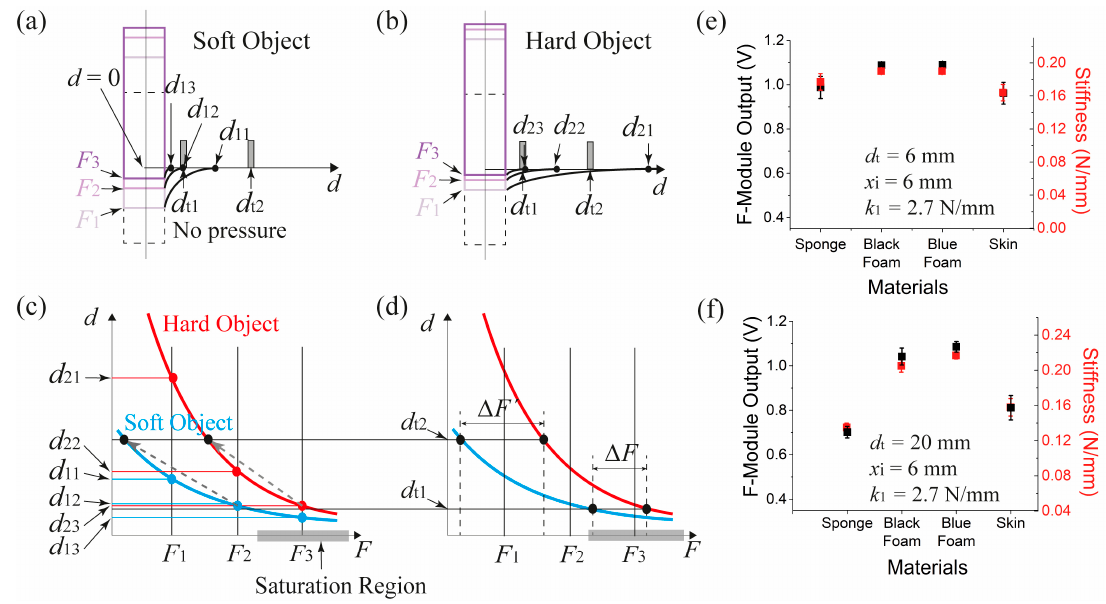
Figure 8. T-module separation dependent stiffness measurement. Illustration of the variation of the indentation profile and IE in case of a softer object ( a ), and ( b ) in case of a harder object. ( c ) Distribution of the IE position depending on applied force. ( d ) t-module position dependent measured forces showing sensing range selection based on t-module separation. Stiffness measurement obtained when the separation was ( e ) 6 mm, and ( f ) 20 mm. For both cases, k 1 was 2.7 N/mm, and x i was 6 mm.